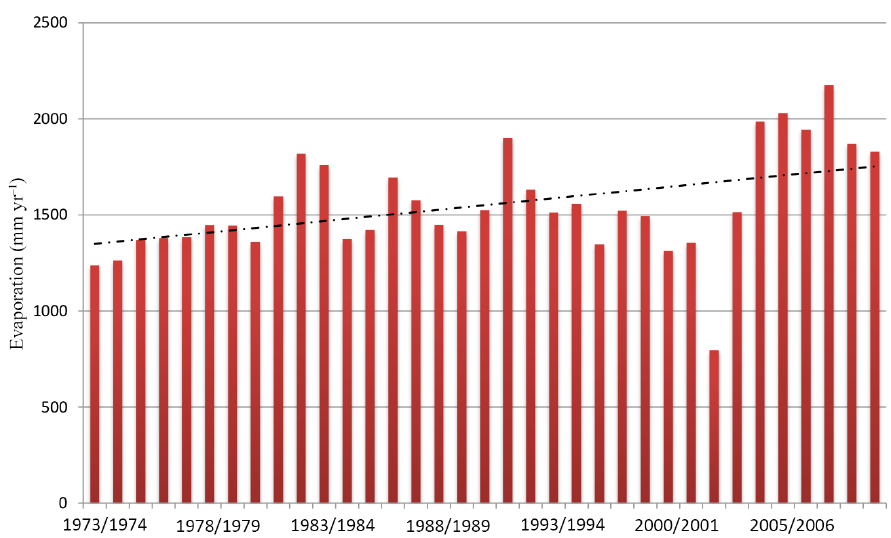
Figure 4. Evaporation trends at Mushandike Irrigation